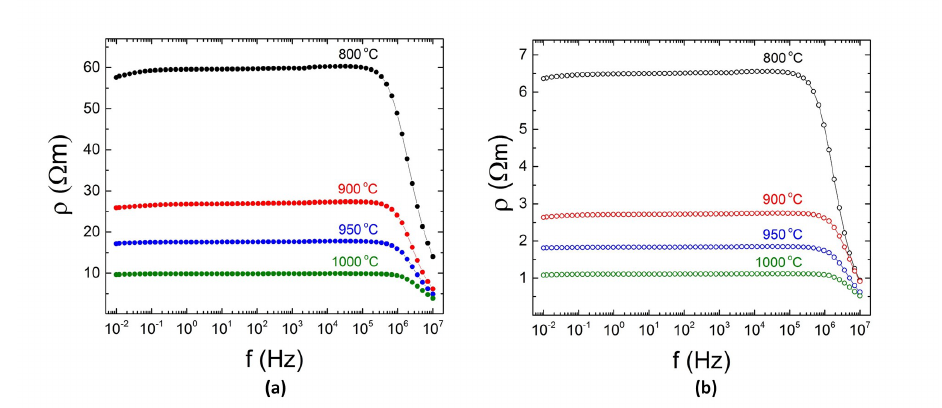
Figure 3. Frequency dependent impedance characterization of composite Ag-LaCoO 3 pellets as a function of pre-sintering temperature. ( a ) The resistivities determined from measurements on LaCoO 3 pre-sintered for 3 h at the given temperatures are shown. For comparison, the corresponding resistivities determined on ALCO5 pellets pre-sintered for 1 h are illustrated ( b ). Compared to the theoretical density value of LaCoO 3 (i.e., 6.94 g/cm 3 ), the density determined